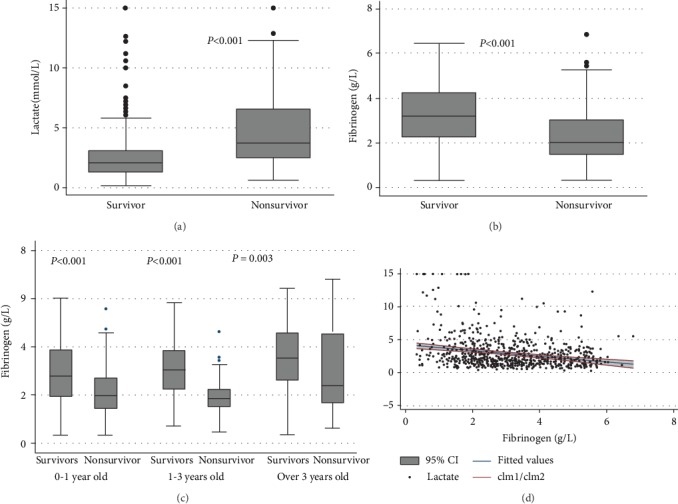
Levels of lactate and fibrinogen levels on PICU admission in patients with sepsis. (a) Lactate levels in survivors and nonsurvivors; (b) fibrinogen levels in survivors and nonsurvivors; (c) fibrinogen levels in children 0-1 year old, 1-3 years old, or over 3 years old; (d) correlation of fibrinogen with lactate levels.